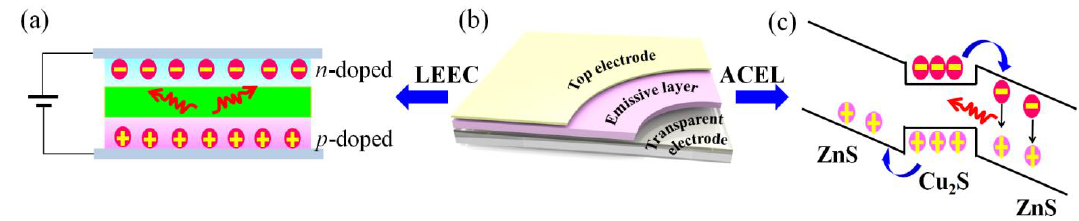
Figure 2: (a) Formation of a p − i − n junction in the LEEC devices under external electrical bias. (b) Schematic illustration of the simple EL device architecture comprising a single emissive layer, top electrode, and transparent bottom electrode. (c) Band structure of the powder ACEL devices under electrical field